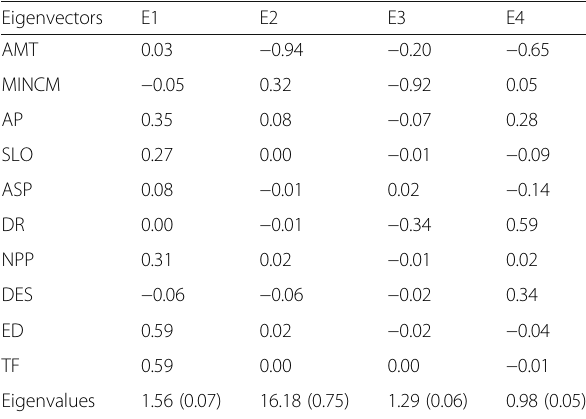
Table 2 Model outputs of the habitat suitability of huemul, where brackets in the eigenvalues present the specialization values